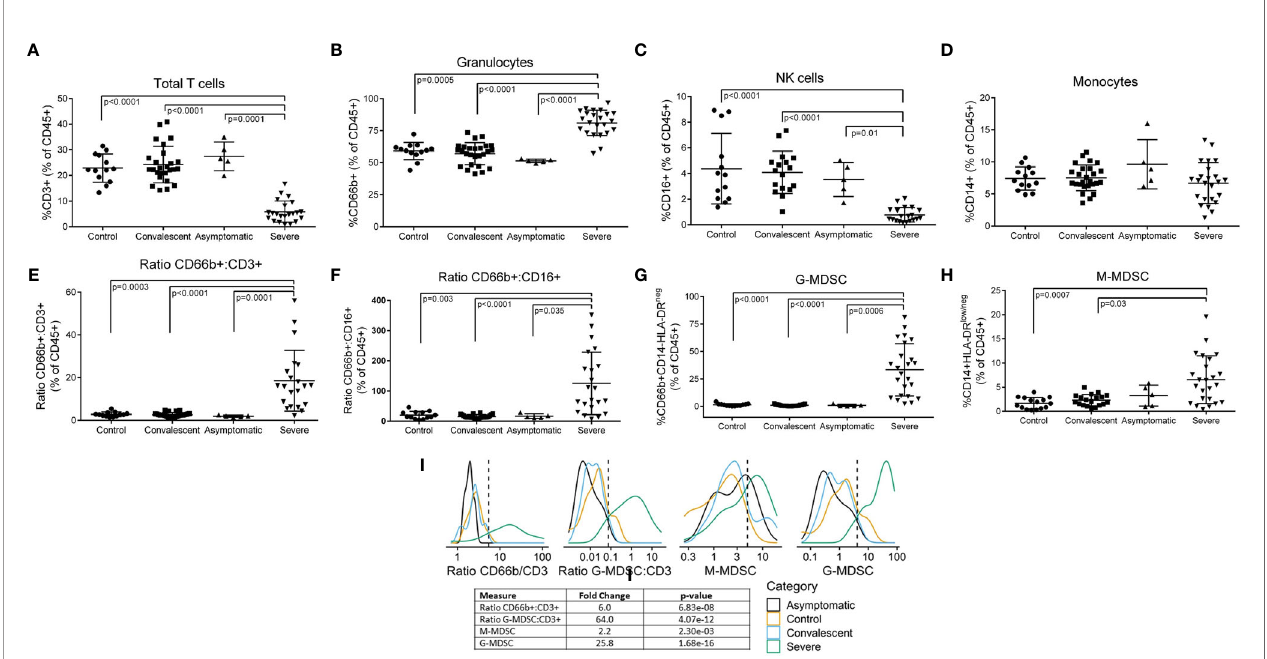
FIGURE 1 | Leukocyte Subpopulations including MDSC in Peripheral Blood of COVID-19 Patients. Whole blood and PBMCs from all participants were analyzed by fl ow cytometry. Percent (A) T cells, (B) granulocytes, (C) NK cells, and (D) monocytes in whole blood. (E) CD66b/CD3 and (F) CD66b/CD16 ratios in whole blood. Percent (G) G-MDSC and (H) M-MDSC in PBMC isolated over fi coll-hypaque; Comparisons between groups were done by one-way ANOVA on ranks and Dunn ’ s Multiple Comparison Test (I) Gaussian Kernel Density using a log10-scaled density of observed values for CD66b:CD3 ratios, G-MDSC : CD3 ratios, M-MDSC, G- MDSC. The vertical, dashed line represents the thresholds obtained in the sensitivity/speci fi city analysis providing the maximum separation between severe COVID- 19 patients and other groups of patients or healthy